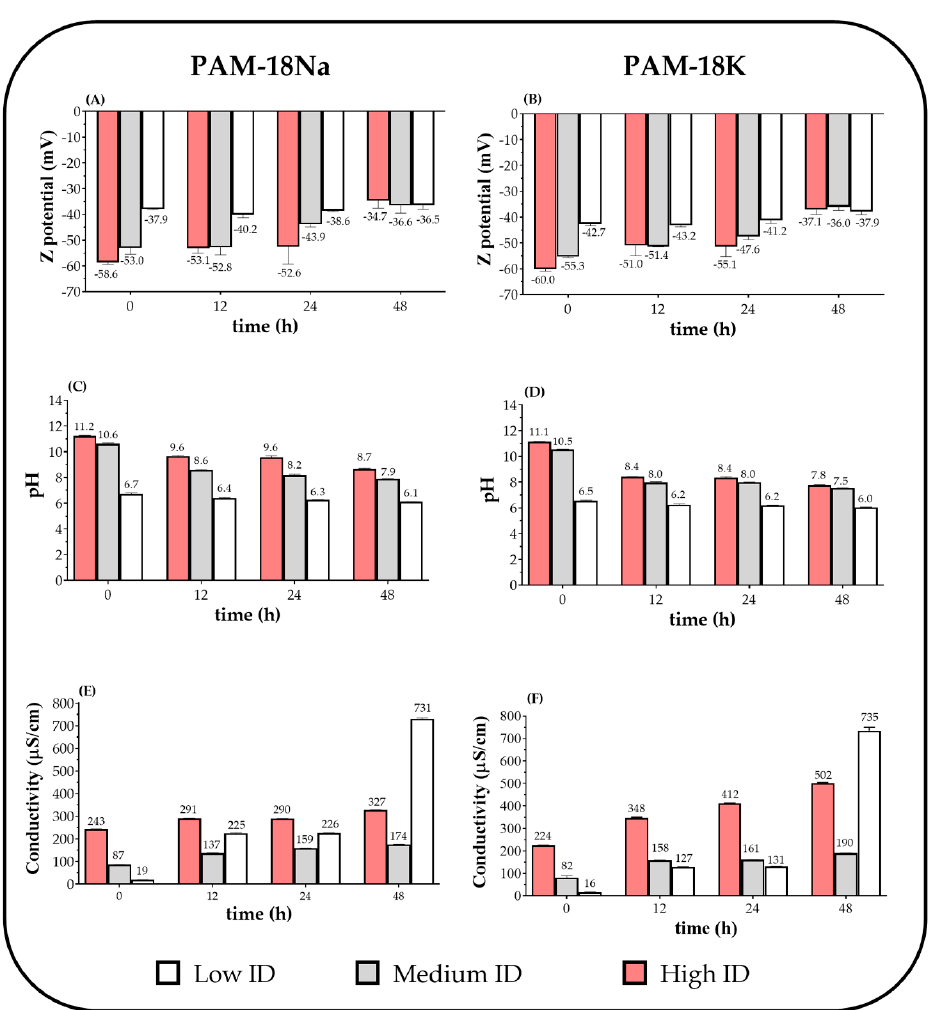
Figure 2. Change of: ( A , B ) zeta potential, ( C , D ) pH, and ( E , F ) conductivity over time for PAM-18Na and PAM-18K polyelectrolytes with different ionization degree (ID) in aqueous media.